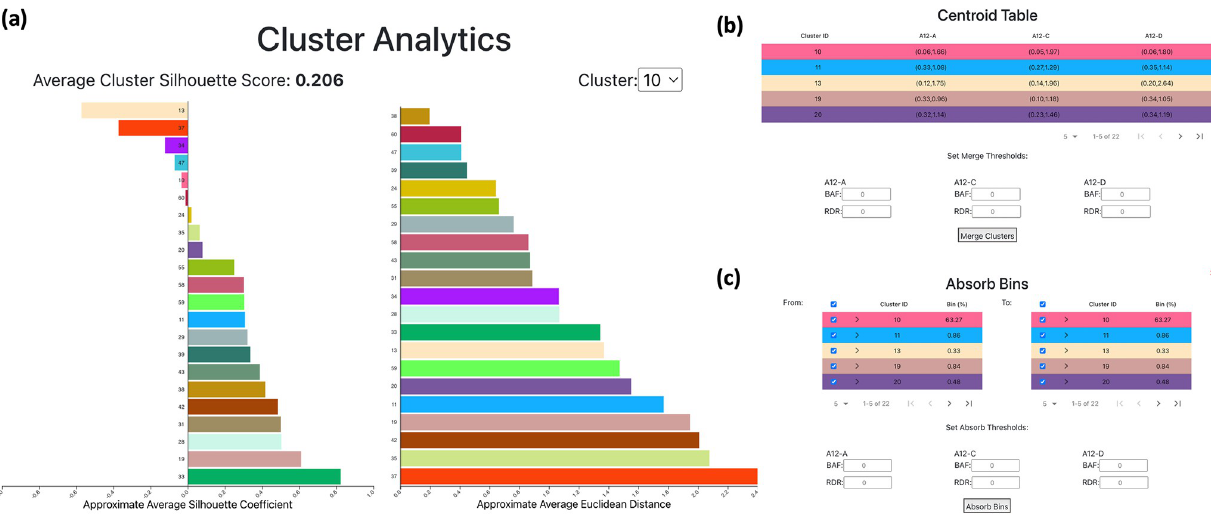
Fig 3. CNAViz provides the user with a variety of analysis tools and automated functions to help generate an accurate segmentation. (a) Average silhouette coefficient bar plot. Above the bar plot, the average of the silhouette scores for each cluster is displayed. Average Euclidean distance bar plot. Displays the average inter-cluster distance of each cluster to the cluster selected in the drop-down above the plot. (b) Centroid Table, illustrating each cluster, and the RDR and BAF values defining each cluster’s centroid in each sample. In this pop-up, we also provide the user with the automated Merge function, which allows the user to set RDR and BAF thresholds per sample. Clusters whose centroids are closer than the user-defined thresholds will subsequently be merged. See Automation for further details. (c) The Absorb Bins pop-up allows the user to select “From” clusters and “To” clusters. All bins in the “From” clusters will be evaluated according to a user-defined threshold, and re-assigned to the closest legal “To” cluster. See Automation for further